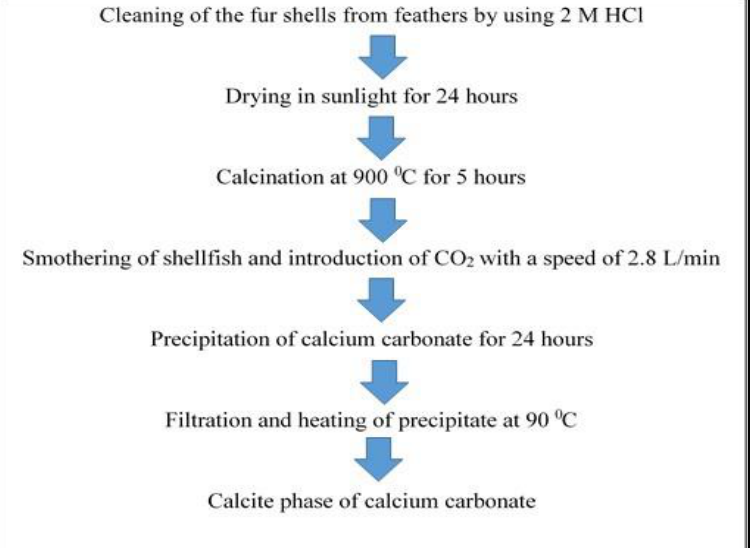
Figure 4. Schematic diagram of extraction of calcite phase from the shellfish.